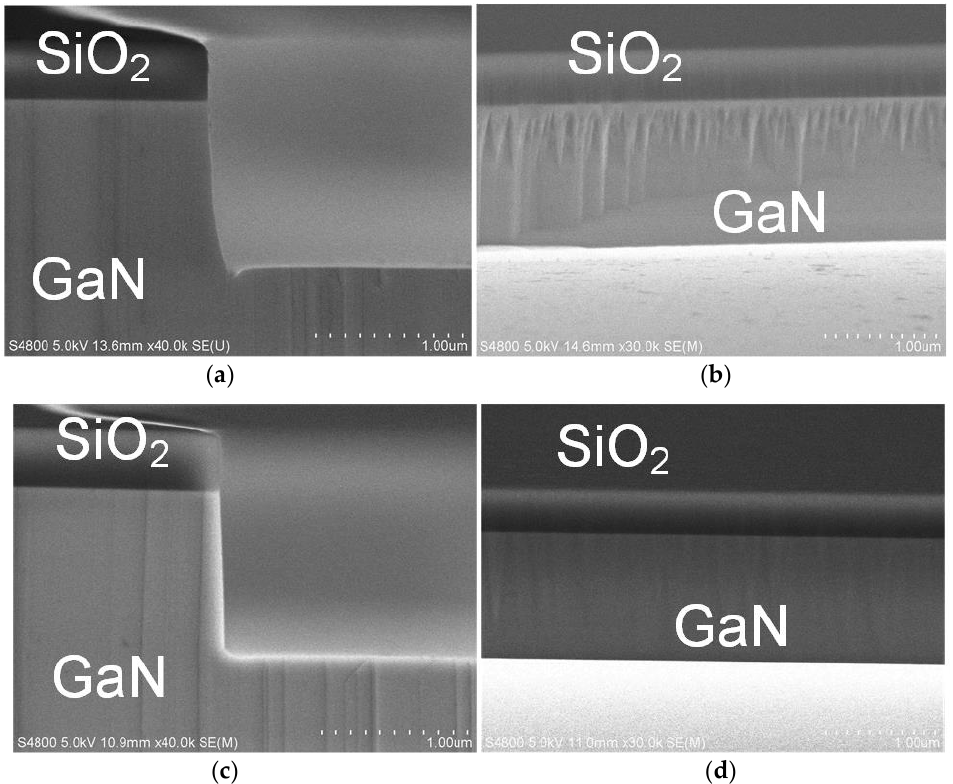
Figure 12. SEM micrographs of SiO 2 -masked GaN etched with the optimum ICP etching recipe before tetramethylammonium hydroxide (TMAH) wet treatment. ( a ) Cross-sectional view of the sidewall; ( b ) sidewall surface. After TMAH wet treatment: ( c ) cross-sectional view of the sidewall; ( d ) sidewall surface.